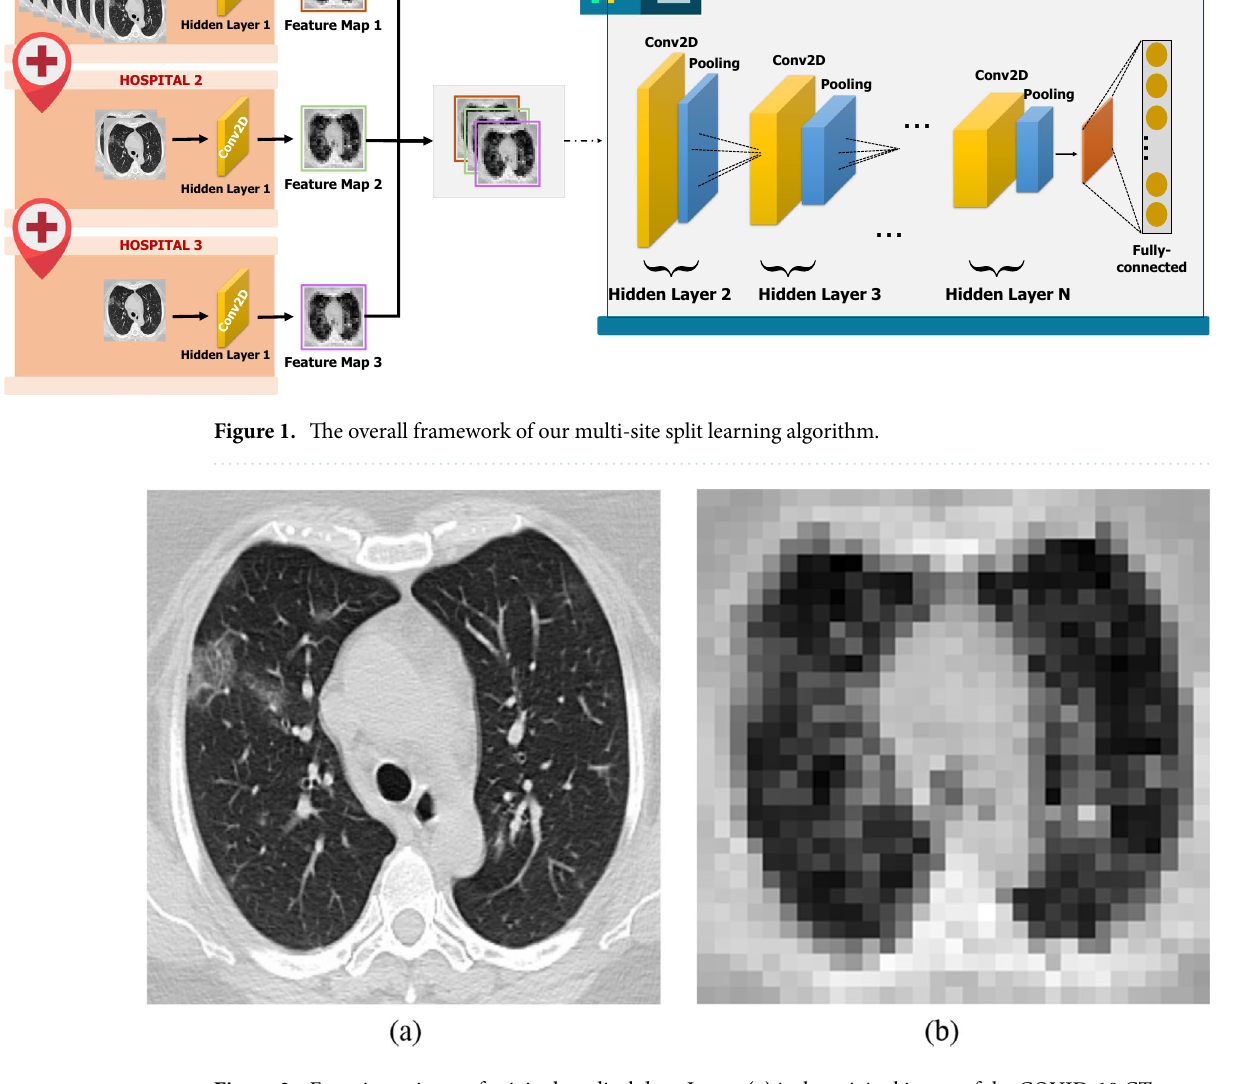
Figure 2. Ensuring privacy of original medical data. Image ( a ) is the original image of the COVID-19 CT scan. Image ( b ) shows the highly distorted image after passing through one hidden layer at the